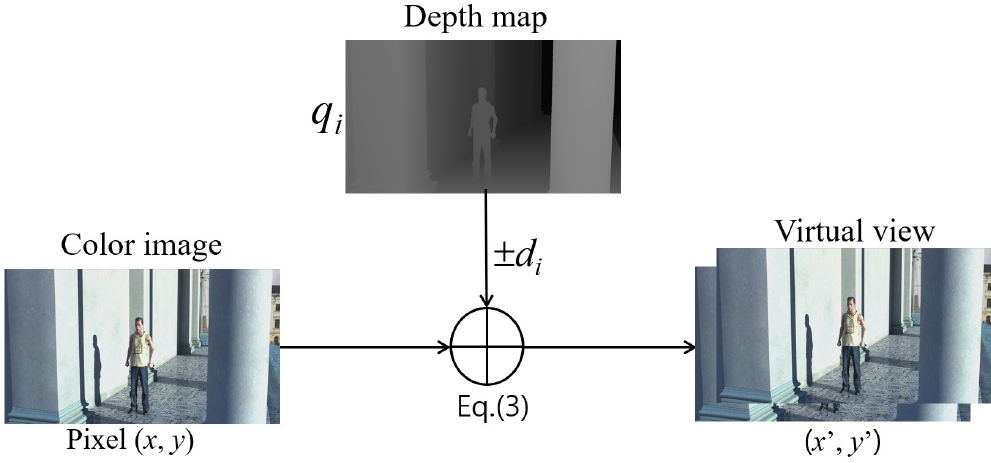
Figure 2. View synthsis based on disparity